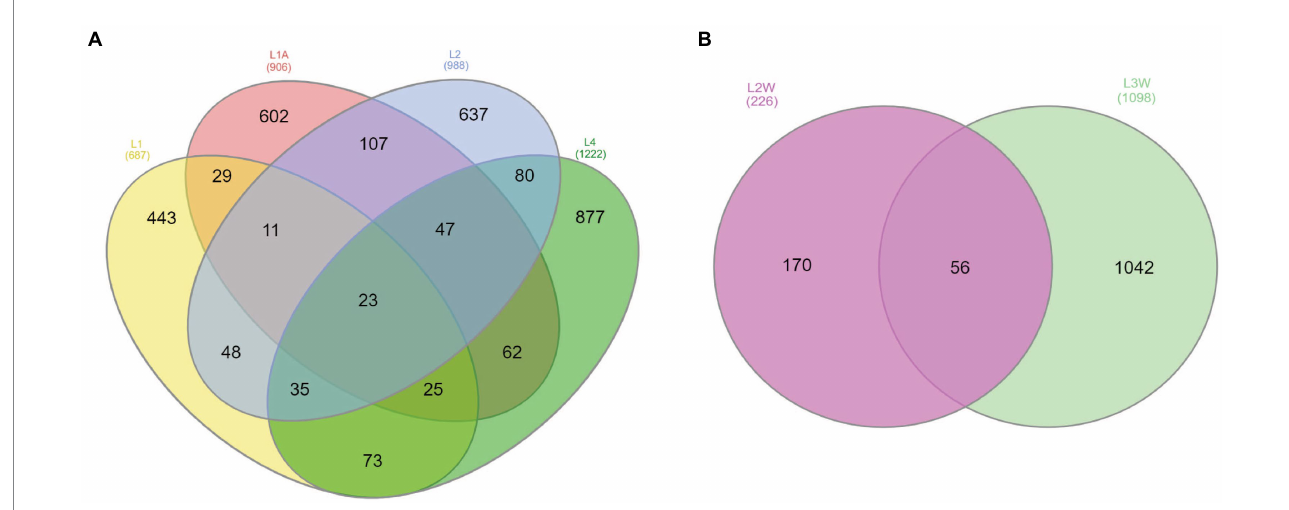
FIGURE 4 Venn diagram of the exclusive and shared ASVs at order-level with >0.1% of the community considered found among sediments (A) and water (B) .